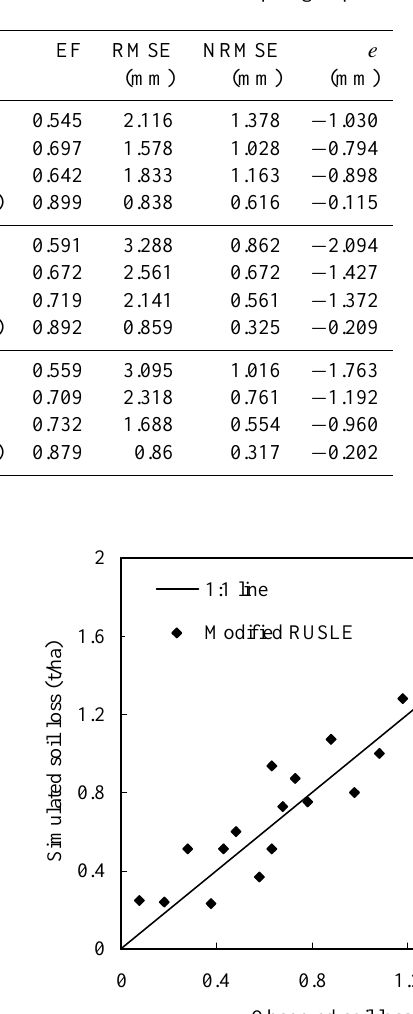
Table 4. Values of model performance evaluation criteria to predict event runoff of the three runoff plot groups